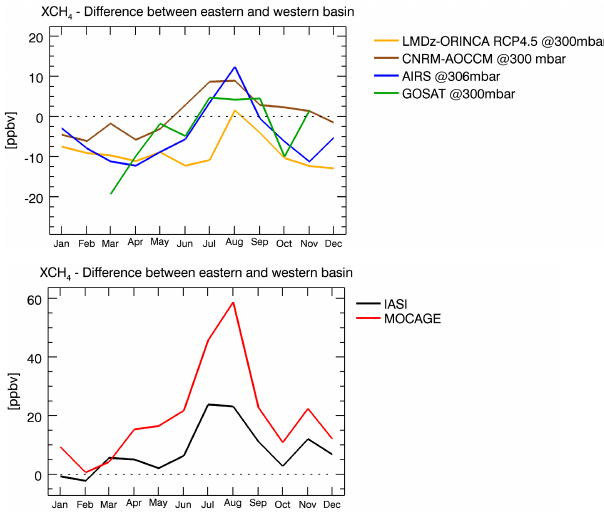
Figure 7. Top: seasonal evolution of the difference in the CH 4 fields between the Eastern and Western MB as measured by AIRS (blue line) and GOSAT (green line) at 306 and 300hPa, respectively and as calculated by LMDz-OR-INCA (yellow line) and CNRM- AOCCM (brown line). Bottom: seasonal evolution of the difference in the CH 4 total columns between the Eastern and Western MB as measured by IASI (black line) and as calculated by MOCAGE (red line). The LMDz-OR-INCA and CNRM-AOCCM data sets cover the climatological period 2001–2010. The MOCAGE and IASI data sets cover the period 2008–2011 whilst the satellite AIRS and GOSAT data sets are representative of the year